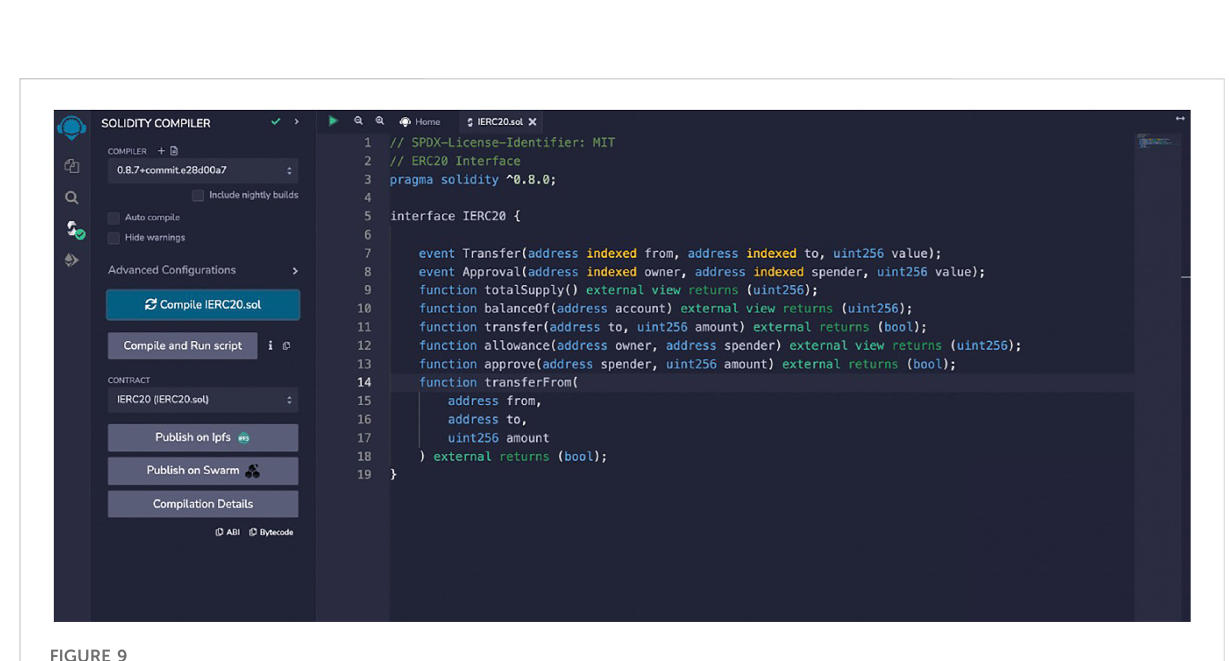
FIGURE 9 Process keeping of the buyer ’ s wallet in case of insuf fi cient